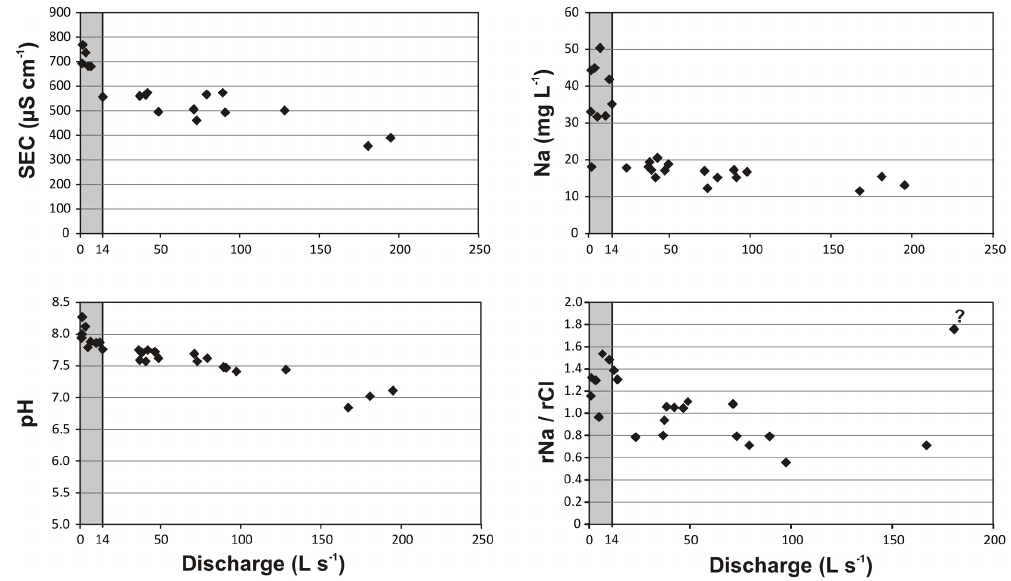
Figure 11. Electrical conductivity, pH, Na content and Na / Cl molar ratio in the Dluga Woda stream observed at monthly intervals during the period July 2011–June 2013, as a function of stream discharge rate measured at gauge station G (see Fig.